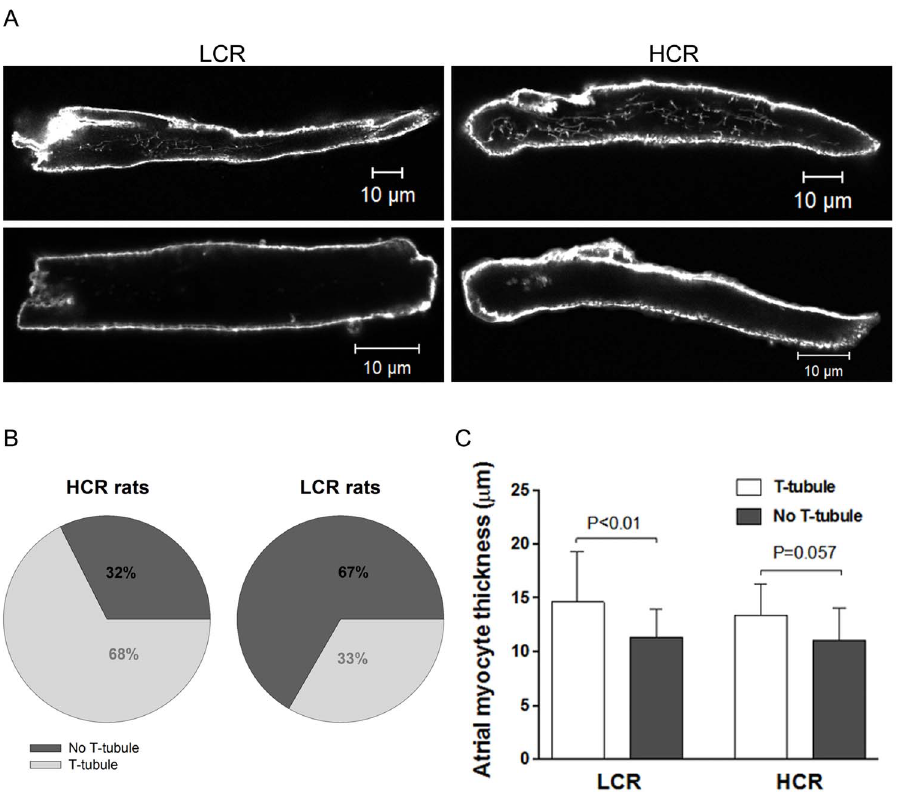
Figure 6. Membrane structures in isolated atrial myocytes. A, Confocal images of Di-8-Anepps stained atrial myocytes with and without T- tubules for Low Capacity Runner (LCR) and High Capacity Runner (HCR) rats. B, Proportion of cells with and without T-tubules for LCR and HCR rats. Absence of T-tubules in the majority of LCR rats may impair Ca 2 + handling. Comparison of cell thickness in cells with and without T-tubules. Data are presented as mean 6 SD. n=57 cells for LCR and 37 cells for HCR.